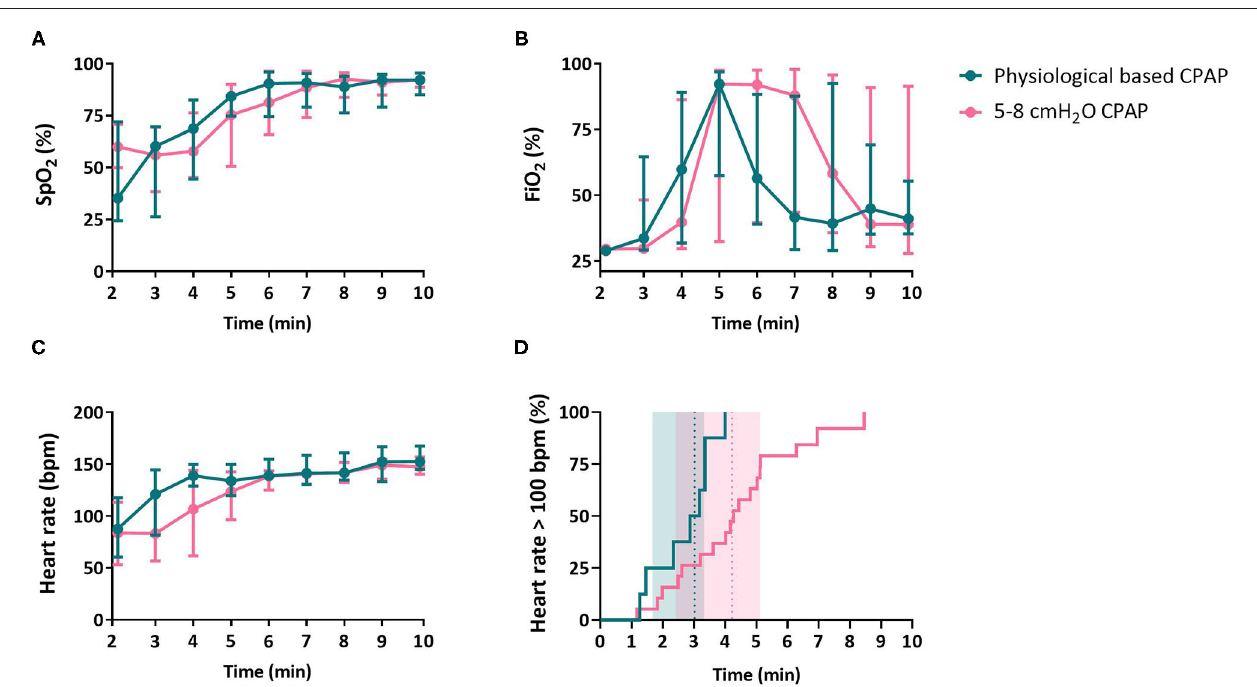
FIGURE 3 | Physiological outcomes. Physiological outcomes oxygen saturation [SpO 2 , (A) ], fraction of inspired oxygen [FiO 2 , (B) ], heart rate (C) and time that heart rate exceeds 100 bpm (D) of infants receiving PB-CPAP and 5–8 cmH 2 O CPAP following the per-protocol analysis. In (D) , heart rate > 100 bpm is illustrated as the incidence over time (continuous line) with the median group time (dotted vertical line) and (shaded) inter quartile range.